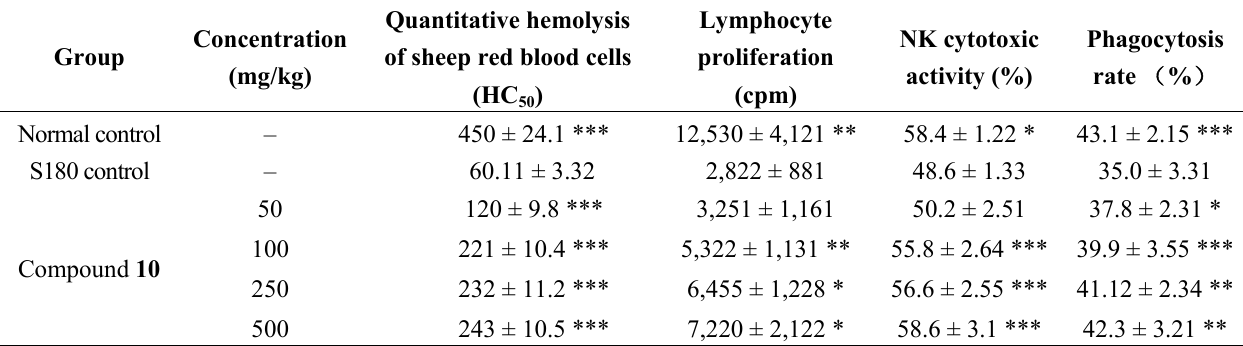
of compound 10 given i.p. in adult 50